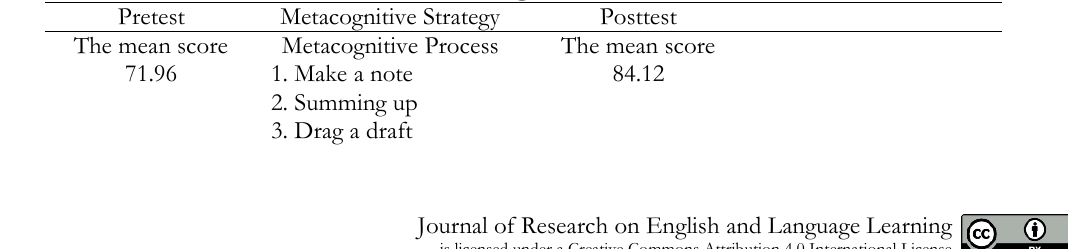
Table 2 . The Metacognitive